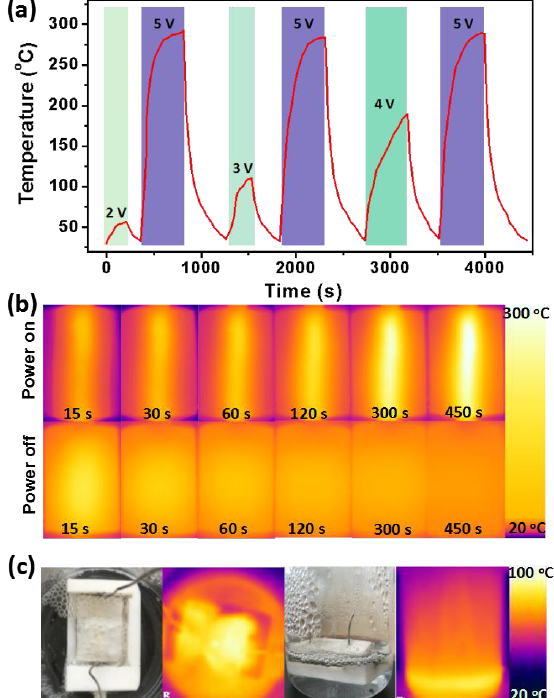
Figure 7. Electro-thermal performance of Composite-1350. ( a ) Cyclic performance of joule heating. ( b ) Infrared thermal images at 5 V and ( c ) ceramic composite was put into a beaker with 50 mL water under 12 V.